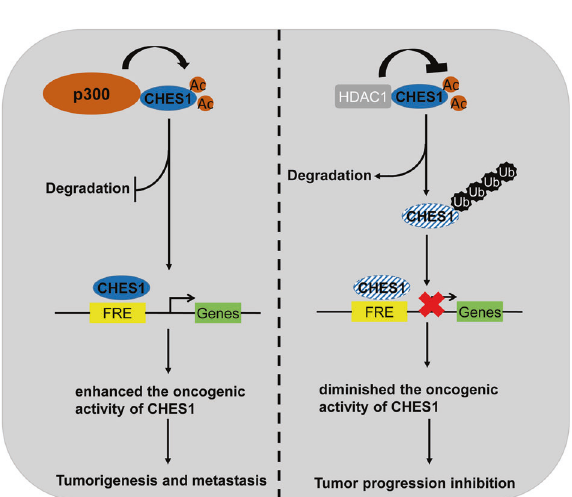
Fig. 7 The schematic diagram of the regulatory mechanism of CHES1 acetylation on the progression of breast cancer. The dynamic acetylation of CHES1 mediated by p300 and HDAC1 regulated the tumorigenesis and invasion of breast cancer cells through modulating the stability and transcriptional activity of